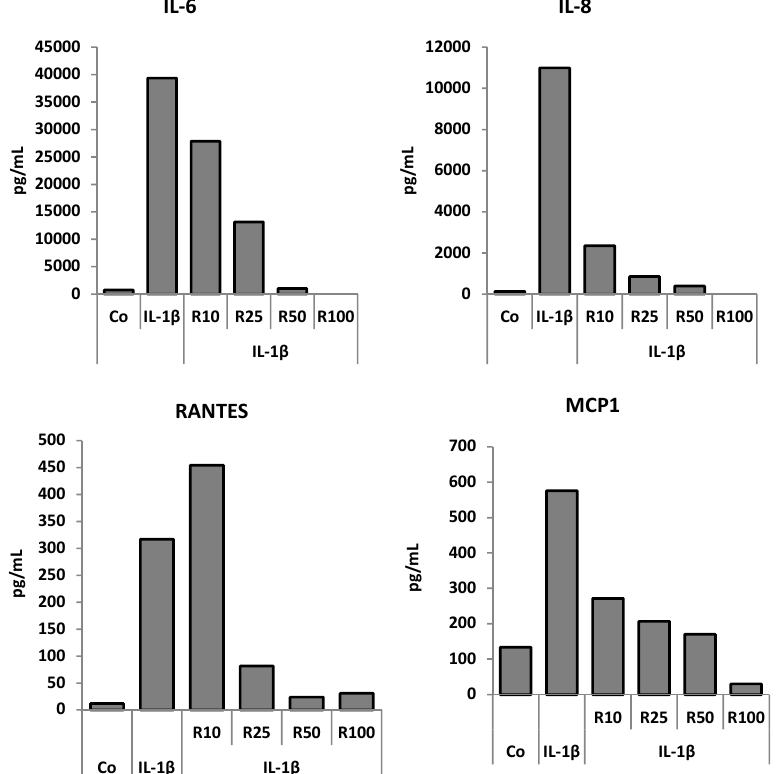
Figure 3. Resveratrol effects on the levels of secreted IL-6, IL-8, Rantes and MCP-1 in HcH monoculture and influence of the IL-1 β treatment. Representative data from one of three experiments are shown. ELISA assessment of the levels of IL-6, IL-8, Rantes, MCP-1 in culture medium. Co: control. Resveratrol (R) in μ M. Pg/mL: picogram/mL.